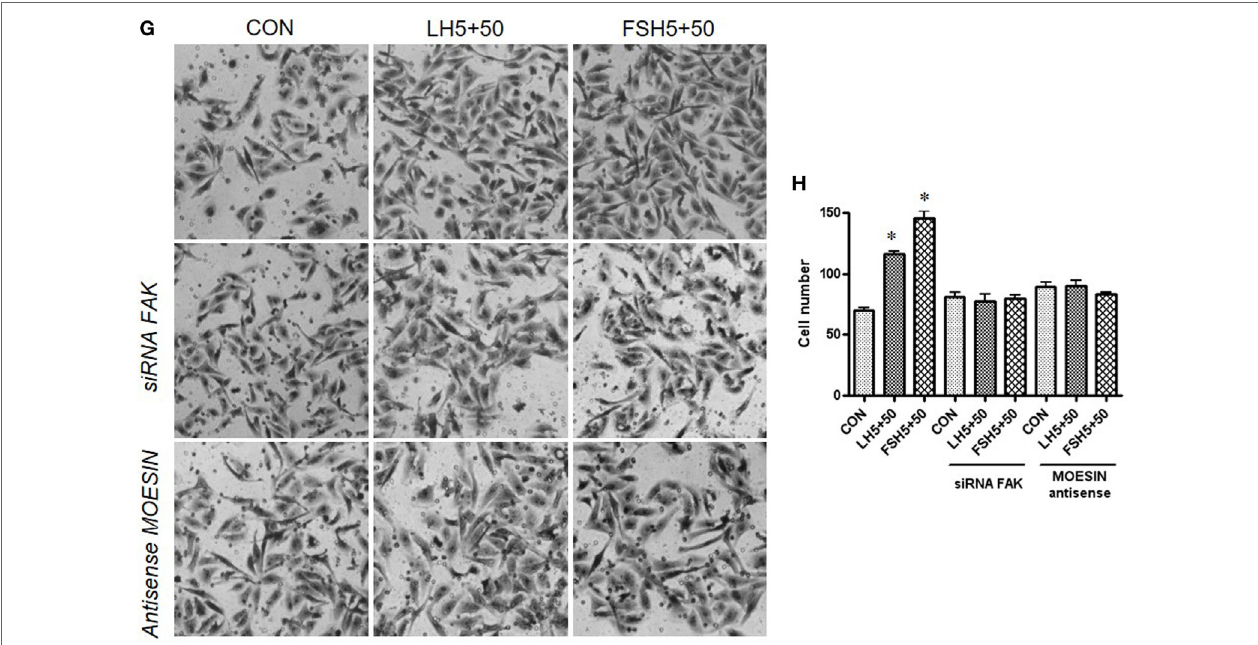
FigUre 4 | Gonadotrophins’ signaling to moesin and focal adhesion kinase (FAK) increase T-47D cell migration and invasion. Breast cancer cells were transfected with 100 nM target shRNA for LHR and follicular-stimulating hormone receptor (FSHR), siRNA for FAK and 75 nM target phosphorothioate oligonucleotides antisense vs. moesin for 48 h and then treated with LH and/or follicle-stimulating hormone (FSH) (5 + 50 mUI/ml) for 48 h. (a,B) Cell migration distances were measured as mean migration distance ( μ m) ± SD. * P ≤ 0.05 vs. control. The experiments were performed in triplicates and representative images are shown. (c–h) Cell invasion was assayed using invasion chambers. Average of invading cells observed, photographed under the microscope at 100 × magnification and counted in three different central fields of triplicate membranes. * P ≤ 0.05 vs. control. The experiments were performed in triplicates. Invasion indexes and representative images are